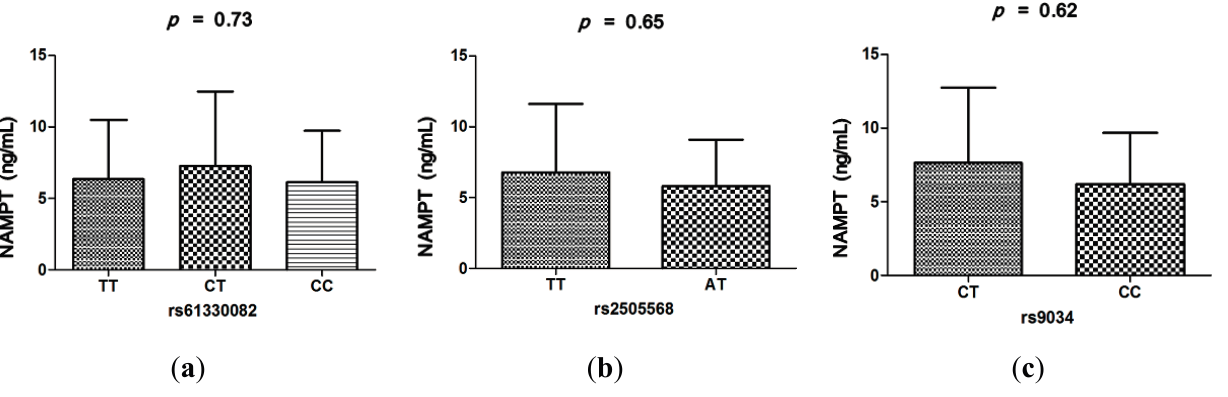
Figure 3. ( a ) No significant relationship was found between serum NAMPT levels and polymorphism of rs61330082 ( p = 0.73); ( b ) No significant relationship was found between serum NAMPT levels and polymorphism of rs2505568 ( p = 0.65); and ( c ) No significant relationship was found between serum NAMPT levels and polymorphism of rs9034 ( p = 0.62). Data are presented as means ±